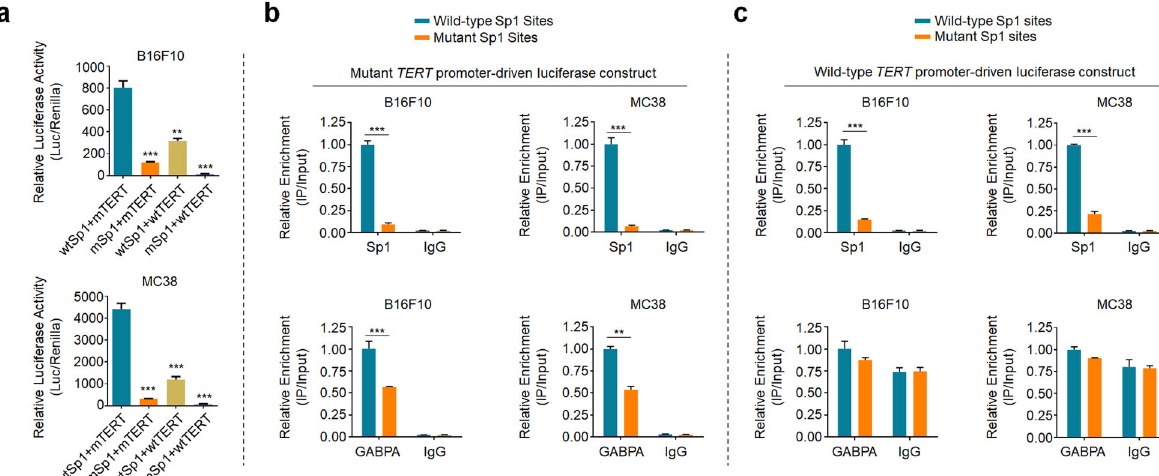
Fig. 7 Mutations of Sp1 binding sites reduce TERT promoter activity and GABPA recruitment. a In vitro luciferase assay was performed to determine the effect of mutations of Sp1 binding sites on the activity of TERT promoter in the indicated cells. wtSp1 wild-type Sp1 binding sites, mSp1 mutant Sp1 binding sites, mTERT TERT promoter with C250T mutation, wtTERT wild-type TERT promoter. Mutant ( b ) and wild-type ( c ) TERT promoter-driven luciferase constructs with mutant or wild-type Sp1 binding sites were transfected into B16F10 and MC38 cells, and the ChIP-qPCR assays were then performed to determine the effect of the presence of Sp1 binding sites on the recruitment of Sp1/GABP to TERT promoter in the indicated cells. Data were shown as mean ± SD. ** P < 0.01; *** P <